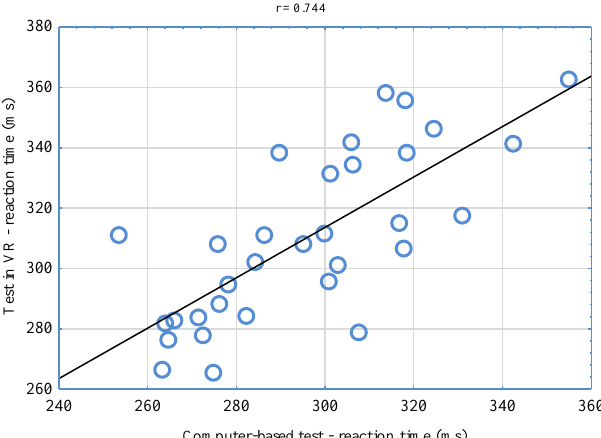
Figure 6. Correlation of the results of simple reaction tests in VR and computer-based ones — right hand.